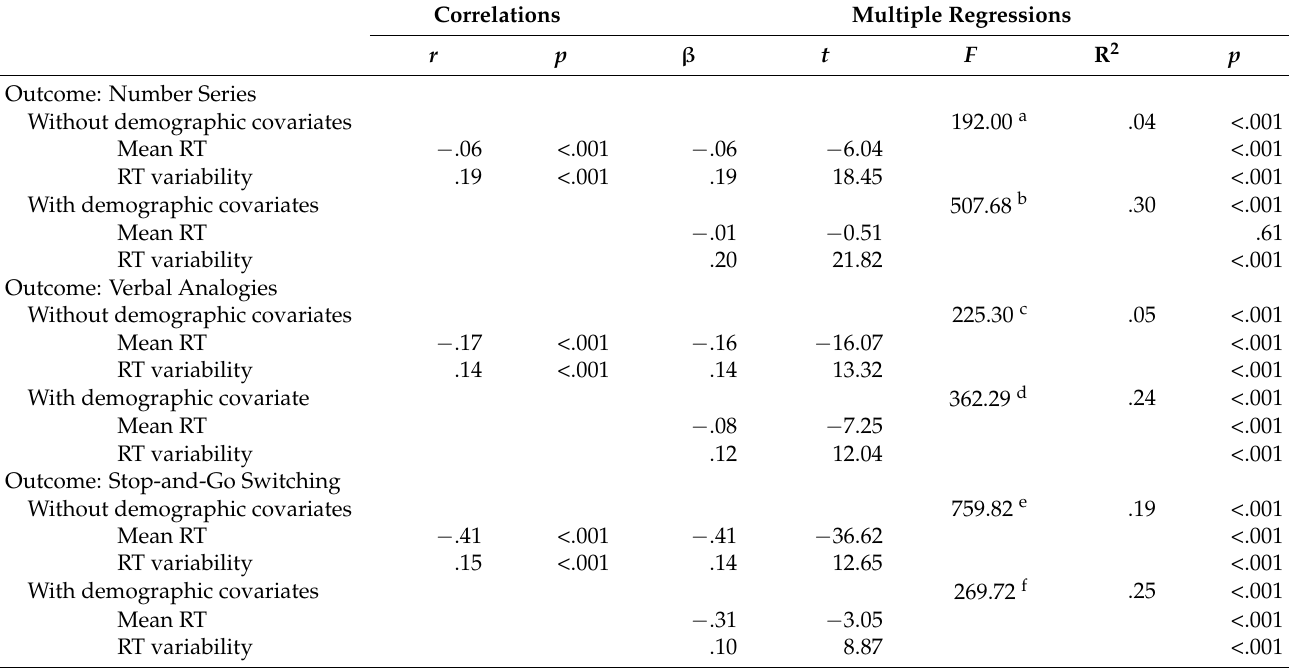
Table 2. Relationships (correlations and standardized regression coefficients) between cognitive test scores and survey item response time components derived from the location-scale model. Correlations Multiple